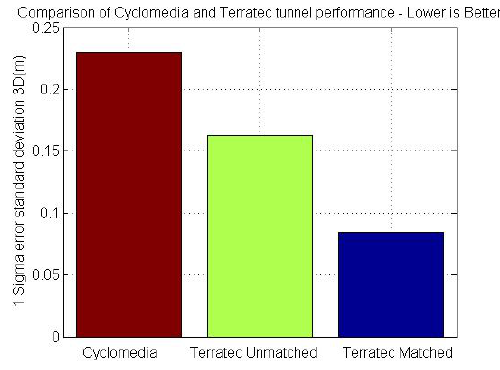
Figure 15: Cyclomedia and TerraTec solutions compared in terms of the 3D positioning error standard